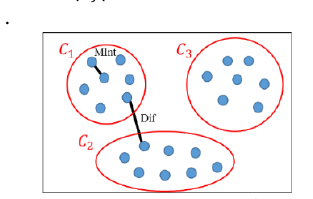
Figure 2 . Visual representation of MInt and